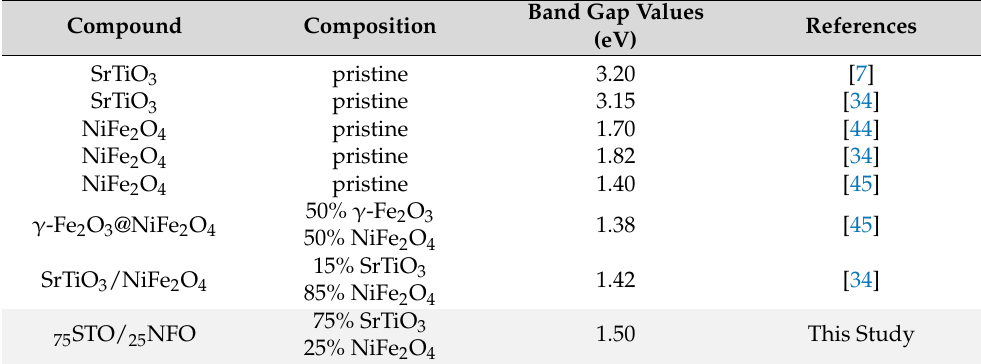
Figure 6. UV-vis DRS of 75 STO/ 25 NFO nanocomposite as hierarchical porous-foam structure and (Inset) corresponding Tauc plot for bandgap determination. Table 3. Bandgap values of NiFe 2 O 4 , SrTiO 3 and SrTiO 3 /NiFe 2 O 4 composite thereof.